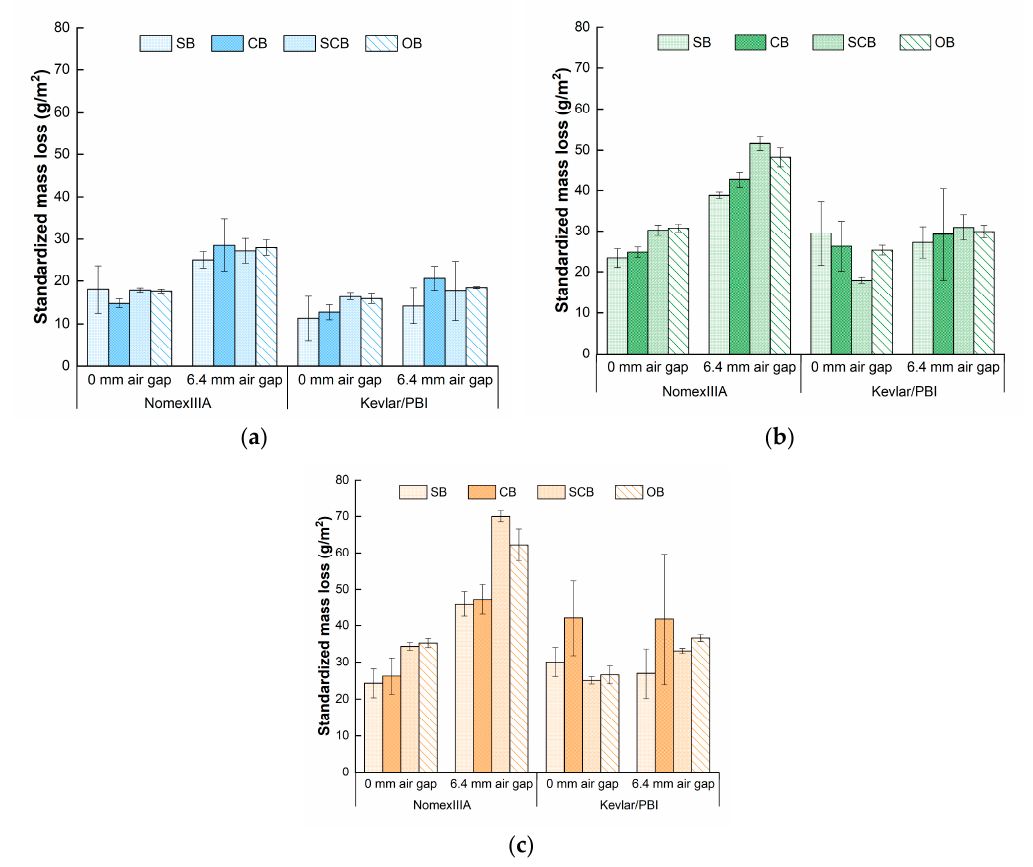
Figure 5. Standardized mass loss under the heat flux of: ( a ) 30 kW/m 2 ; ( b ) 40 kW/m 2 ; ( c ) 50 kW/m 2 . SB—standard boundary; CB—confined boundary; SCB—semiconfined boundary; OB—open boundary.